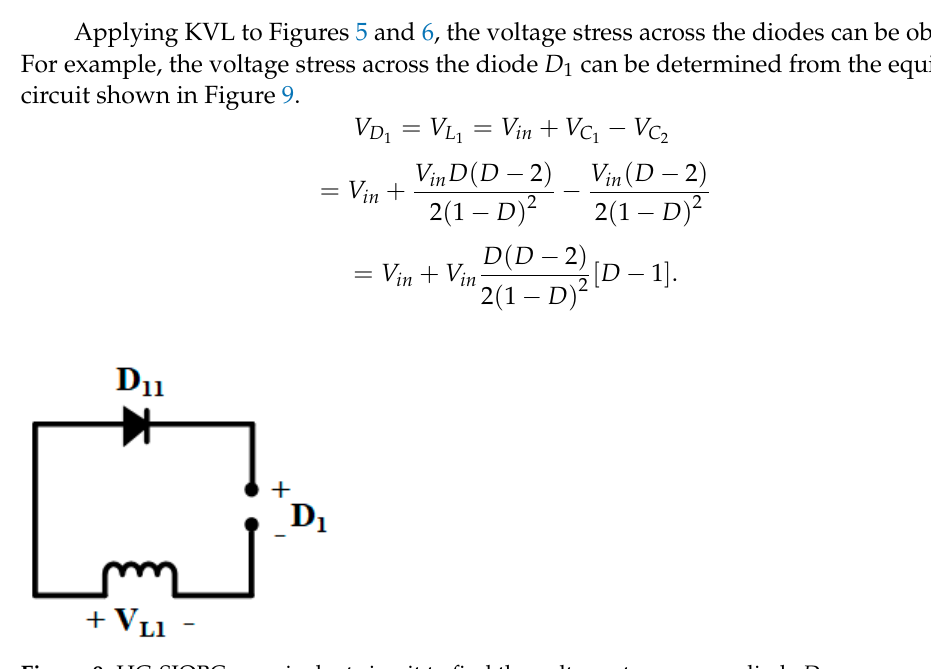
Figure 9. HG-SIQBC—equivalent circuit to find the voltage stress across diode D 1 . Figure 9 . HG-SIQBC—equivalent circuit to find the voltage stress across diode D 1 .